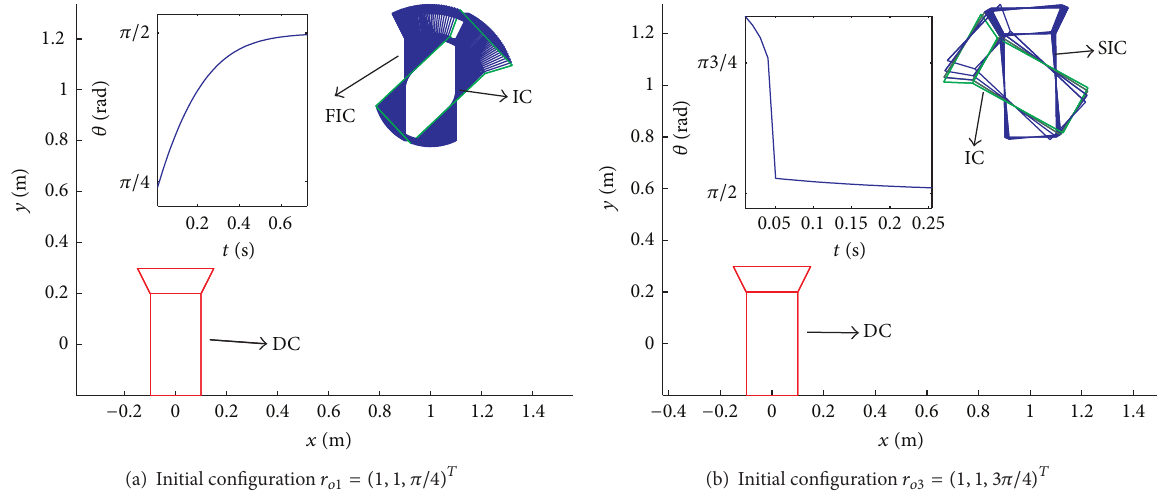
Figure 6: The first step: the robot trajectory. (a) The initial configuration is 𝑟 𝑜1 = (1,1, 𝜋/4) 𝑇 ; (b) the initial configuration is 𝑟 𝑜3 = (1,1, 3𝜋/4) 𝑇 . DC is the desired configuration, FIC is the intermediate configuration of the first step, and IC is the initial configuration. Both figures show that the orientation of the robot is towards 𝜋/2 (the orientation of desired configuration). In this step, the robot is moving from IC to SIC.